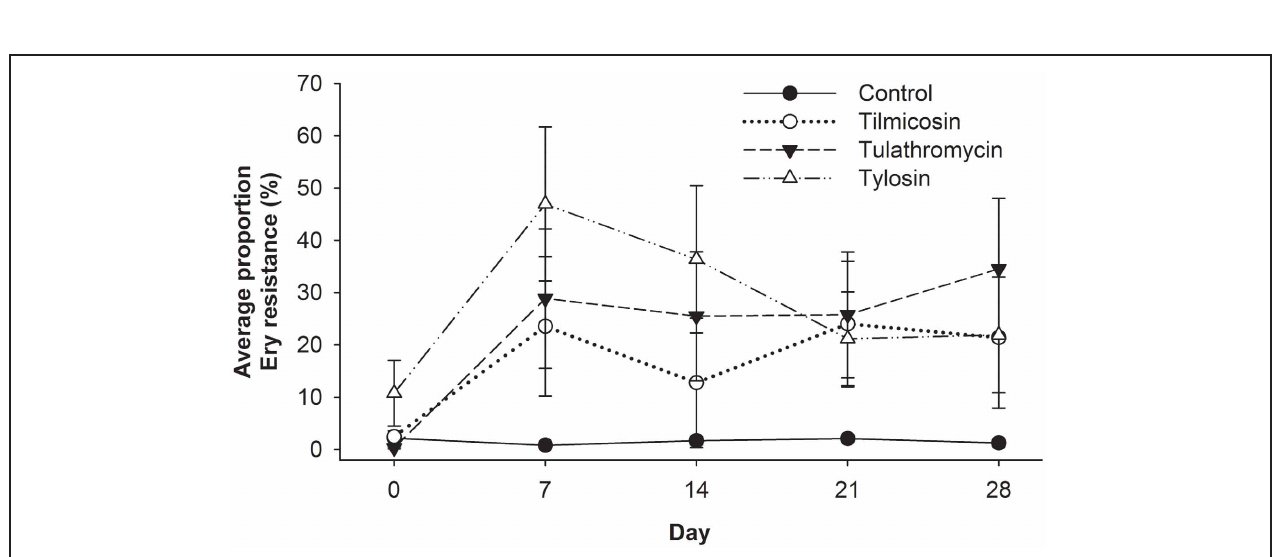
FIGURE 5 | Proportion of erythromycin-resistant faecal enterococci isolates for each of the five sampling events over 28 days study period, with day 0 samples collected prior to antibiotic treatment. From day 7